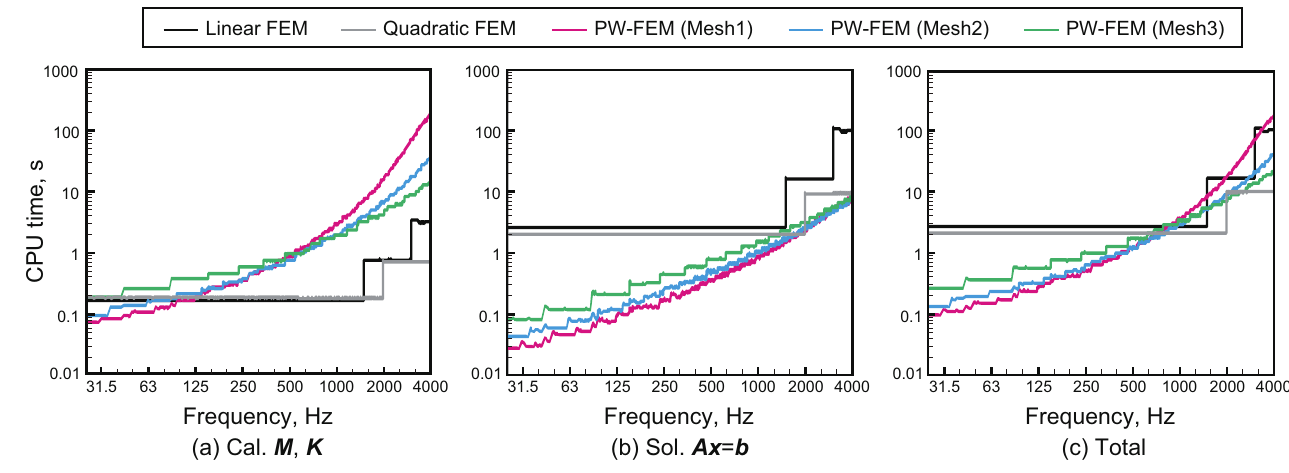
Figure 12. Comparisons of the CPU times on sequential calculation of the PW-FEM with Mesh 1, Mesh 2, and Mesh 3 and the classical linear and quadratic FEMs: ( a ) CPU times in constructing the global stiffness and mass matrix, K and M , ( b ) CPU times in solving the linear system of equations, and ( c ) CPU times in